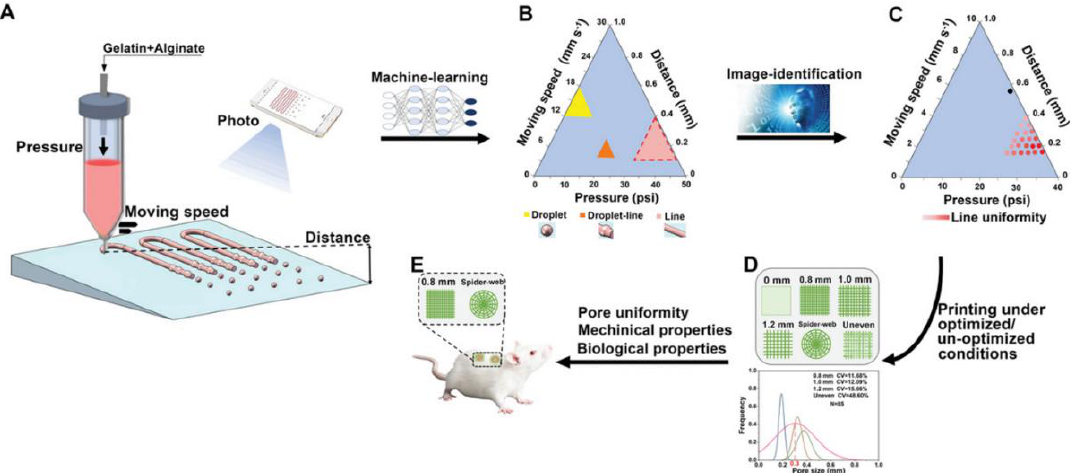
Figure 4. Machine-learning-based optimization of scaffold design and 3D printing parameters for wound healing. ( A ) Schematic of extrusion printing and layer-based photo acquisition. ( B ) Modeling of printed morphology based on input parameters. ( C ) Identification of input parameters for desired morphologies. ( D ) Generation of variable layer geometries using optimized printing